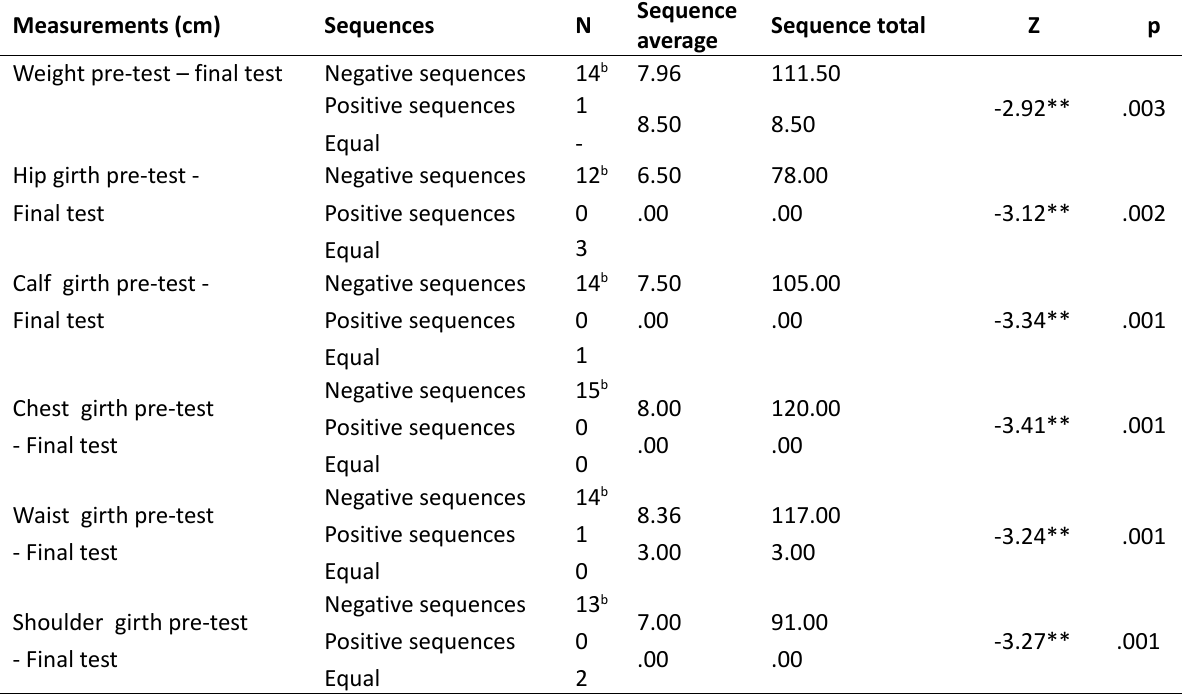
Table 3. Comparison on some circumference measurement values of the women Measurements (cm)